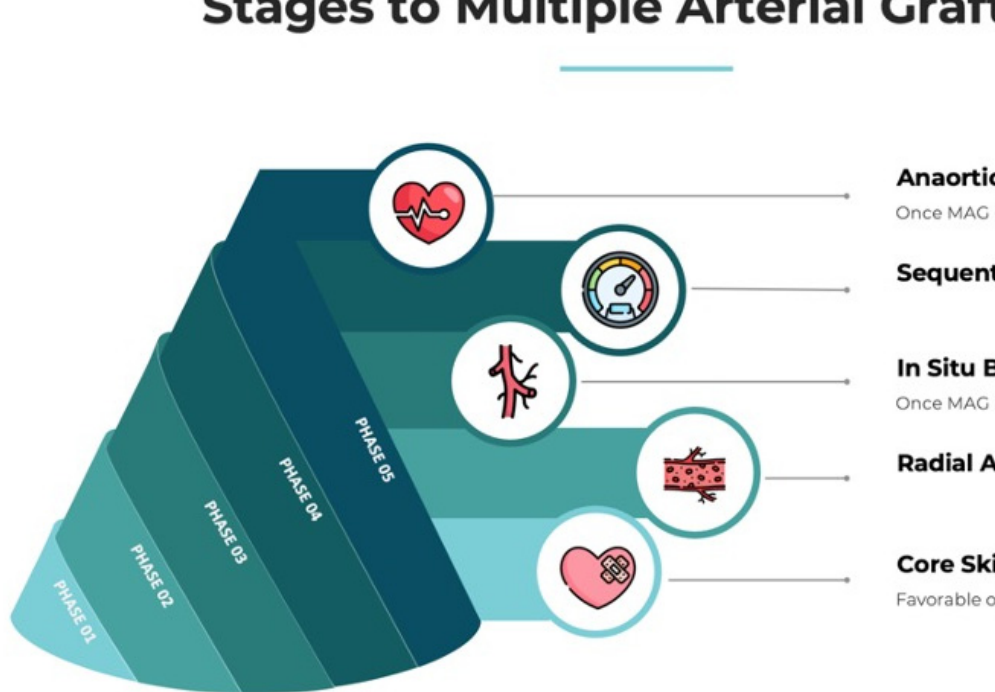
Figure 2. Integrating multiple arterial grafting (MAG) in coronary artery bypass grafting (CABG) programs. Adapted from Vallely et al. [88]. BITA—bilateral internal thoracic artery; OPCAB—off-pump CABG; SVG—saphenous vein graft.